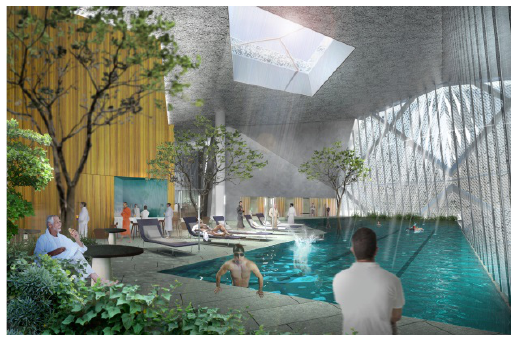
Fig 8(d) Kinetic Screening System regulating sun light Fig 8(e) Kinetic Screening System providing